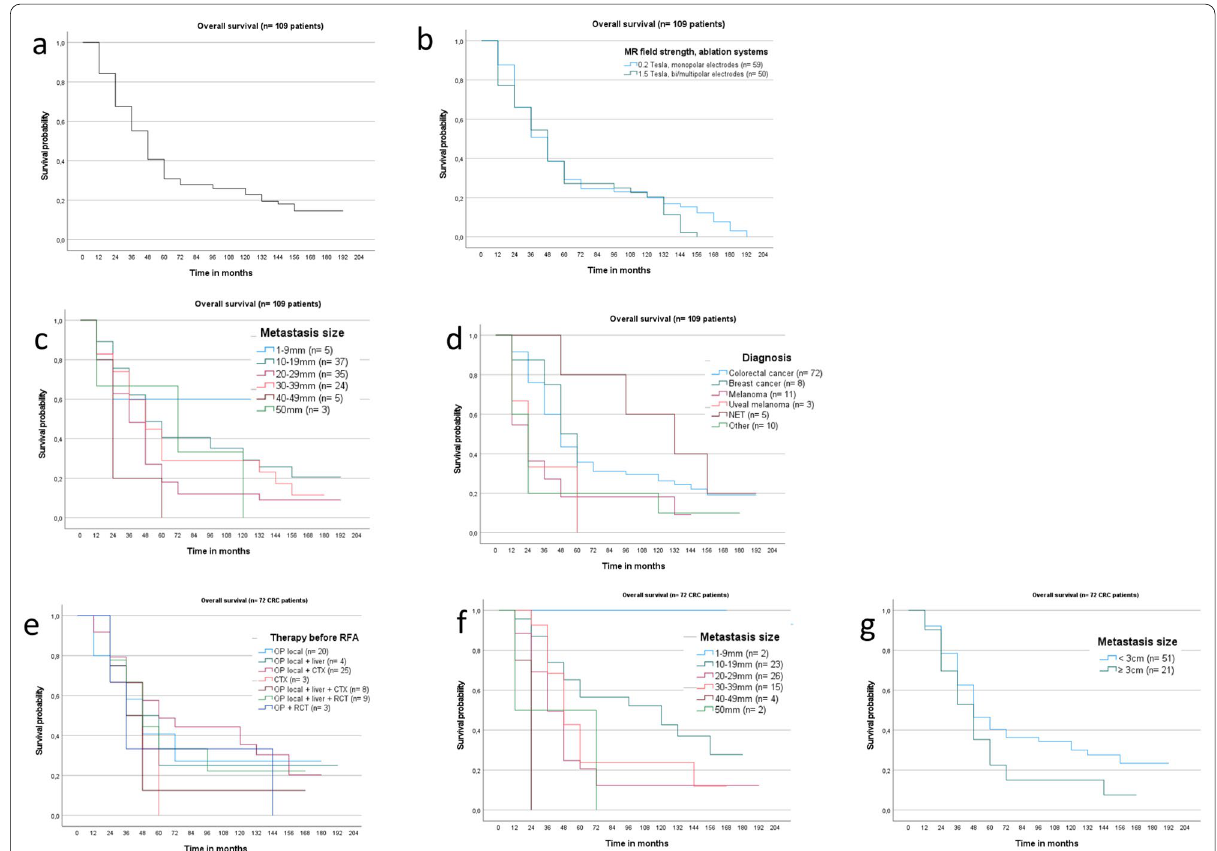
Fig. 2 Kaplan–Meier curve for OS of the whole study cohort ( a n 109 patients, median 39.2 months, SD 3.7) and respectively for procedures = performed with monopolar electrodes at 0.2 T and bi/multipolar electrodes at 1.5 T ( b median 36.5 vs. 37.5 months; 95% CI respectively 28.3–44.6 and 25.7–49.3). RFA treated lesions up to 9 mm revealed the highest OS ( c median not reached). OS according to the primary tumours, revealed significant differences with highest OS for patients with NET ( d median 130.5 months, SD 46.4, 95% CI 39.4–221.5; p 0.026) and lowest survival = rates for uveal melanoma patients (median 15.0 months, SD 3.8, 95% CI 7.5–22.5). In 72 CRC patients, highest OS was documented for therapy combination of surgery and chemotherapy ( e median 53.0 months, SD 16.1; 95% CI 15.5–90.5) and lesions up to 19 mm ( f ). No significant OS differences were detected between treated lesions smaller or larger than 30 mm ( g p =